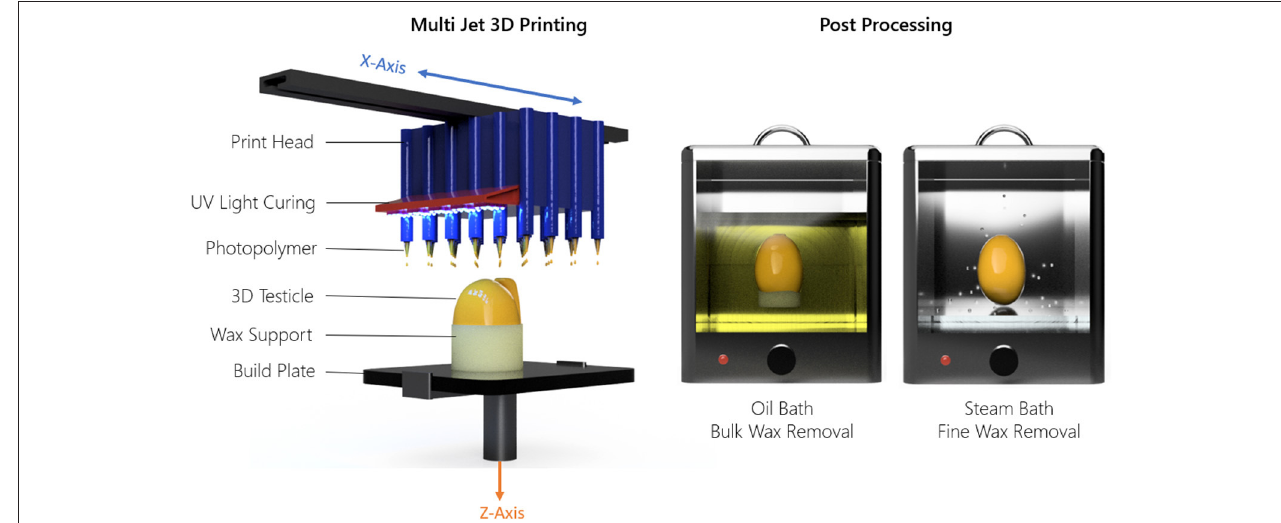
FIGURE 2 | Material jetting technique and post-processing method used to 3D print the testicle prostheses.